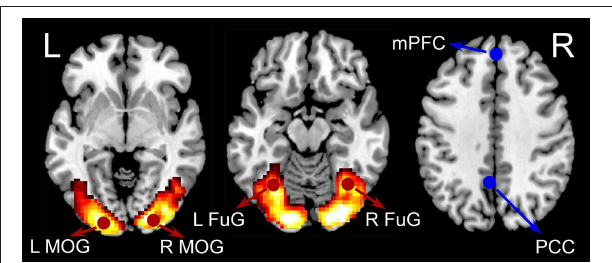
FIGURE 1 | The group-level BOLD activation map for visual checkerboard stimuli (hot color coded). Six ROIs used in the current analyses were displayed in red (activated) or blue (inactivated). The four activated ROIs were left middle occipital gyrus (LMOG) [MNI coordinates: right middle occipital gyrus (RMOG) (24, − 91, 1), left fusiform gyrus (LFuG) ( − 33, − 61, − 14), and right fusiform gyrus (RFuG) (36, − 58, − 11). The two inactivated ROIs were medial prefrontal cortex (mPFC) (0, 51, 32) and posterior cingulate cortex (PCC) ( − 5, − 49,